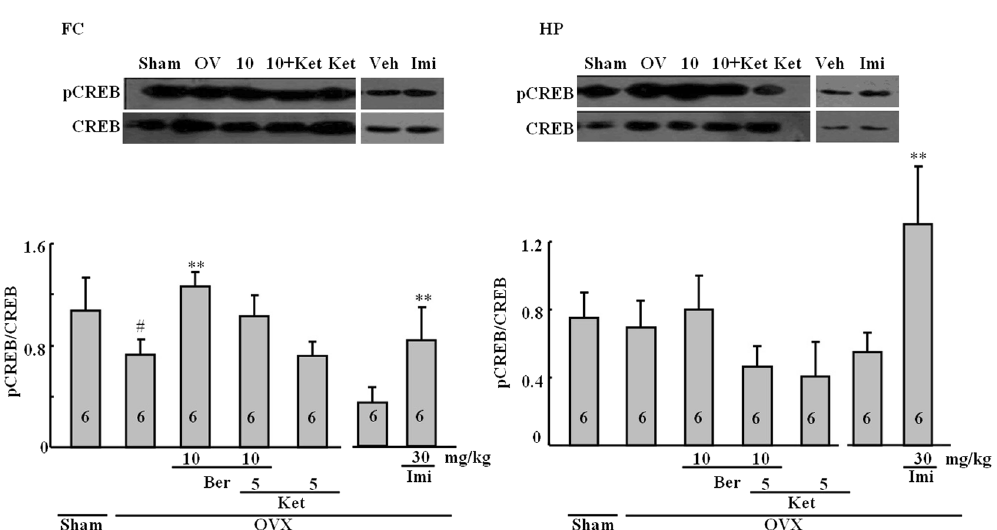
Figure 4. Representative western blots for CREB and pCREB. The frontal cortex (FC; left) and the hippocampus (HP; right). Figures represent the pCREB/CREB ratios in the FC and HP. Group conditions are indicated by abbreviations and doses by numbers: Sham (sham treatment), OVX (ovariectomy), Ber (berberine, 5 or 10 mg/kg), Ket (ketanserin, 5 mg/kg) and Imi (imipramine, 30 mg/kg). Symbols represent significant post hoc comparisons: Tukey’s HSD, # P < 0.05 vs. sham, ** P < 0.05 vs. OVX